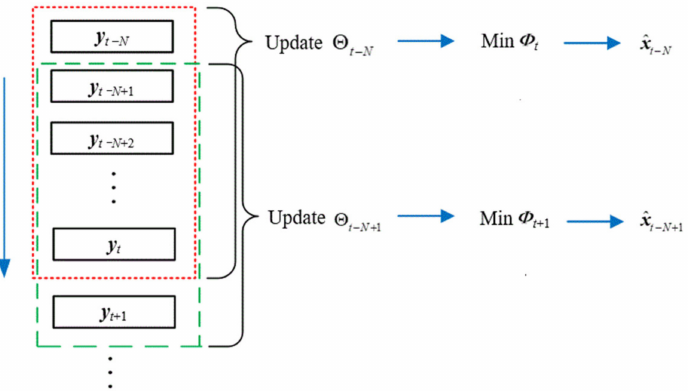
Figure 2. Moving horizon estimation